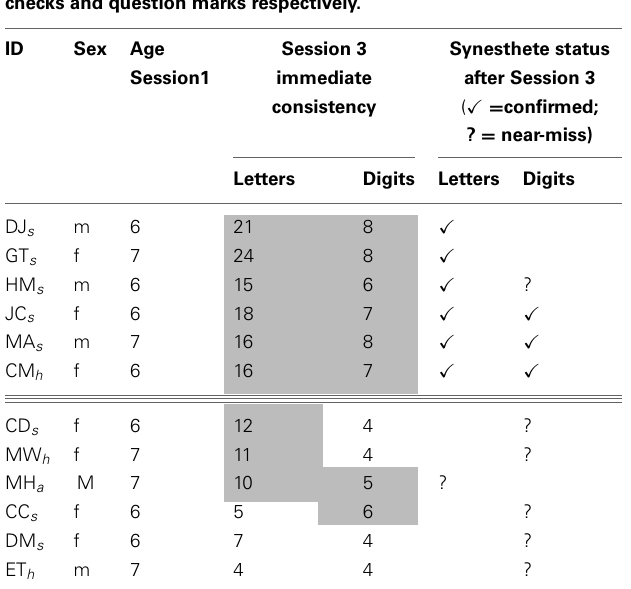
Table 2 | Session 3 synesthetes and “near-misses,” indicated by checks and question marks respectively.